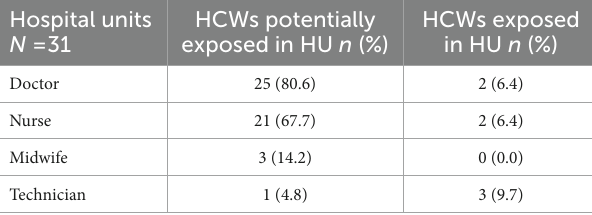
TABLE 3 Results HCWs potentially exposed or exposed in hospital unit.